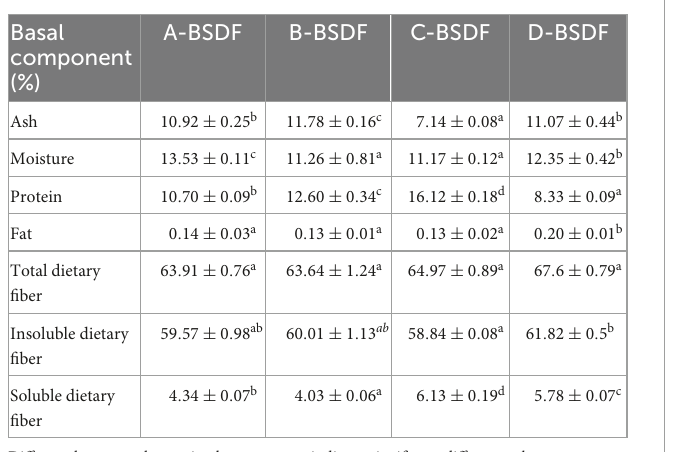
TABLE 1 Basal composition and content of different bamboo shoots.